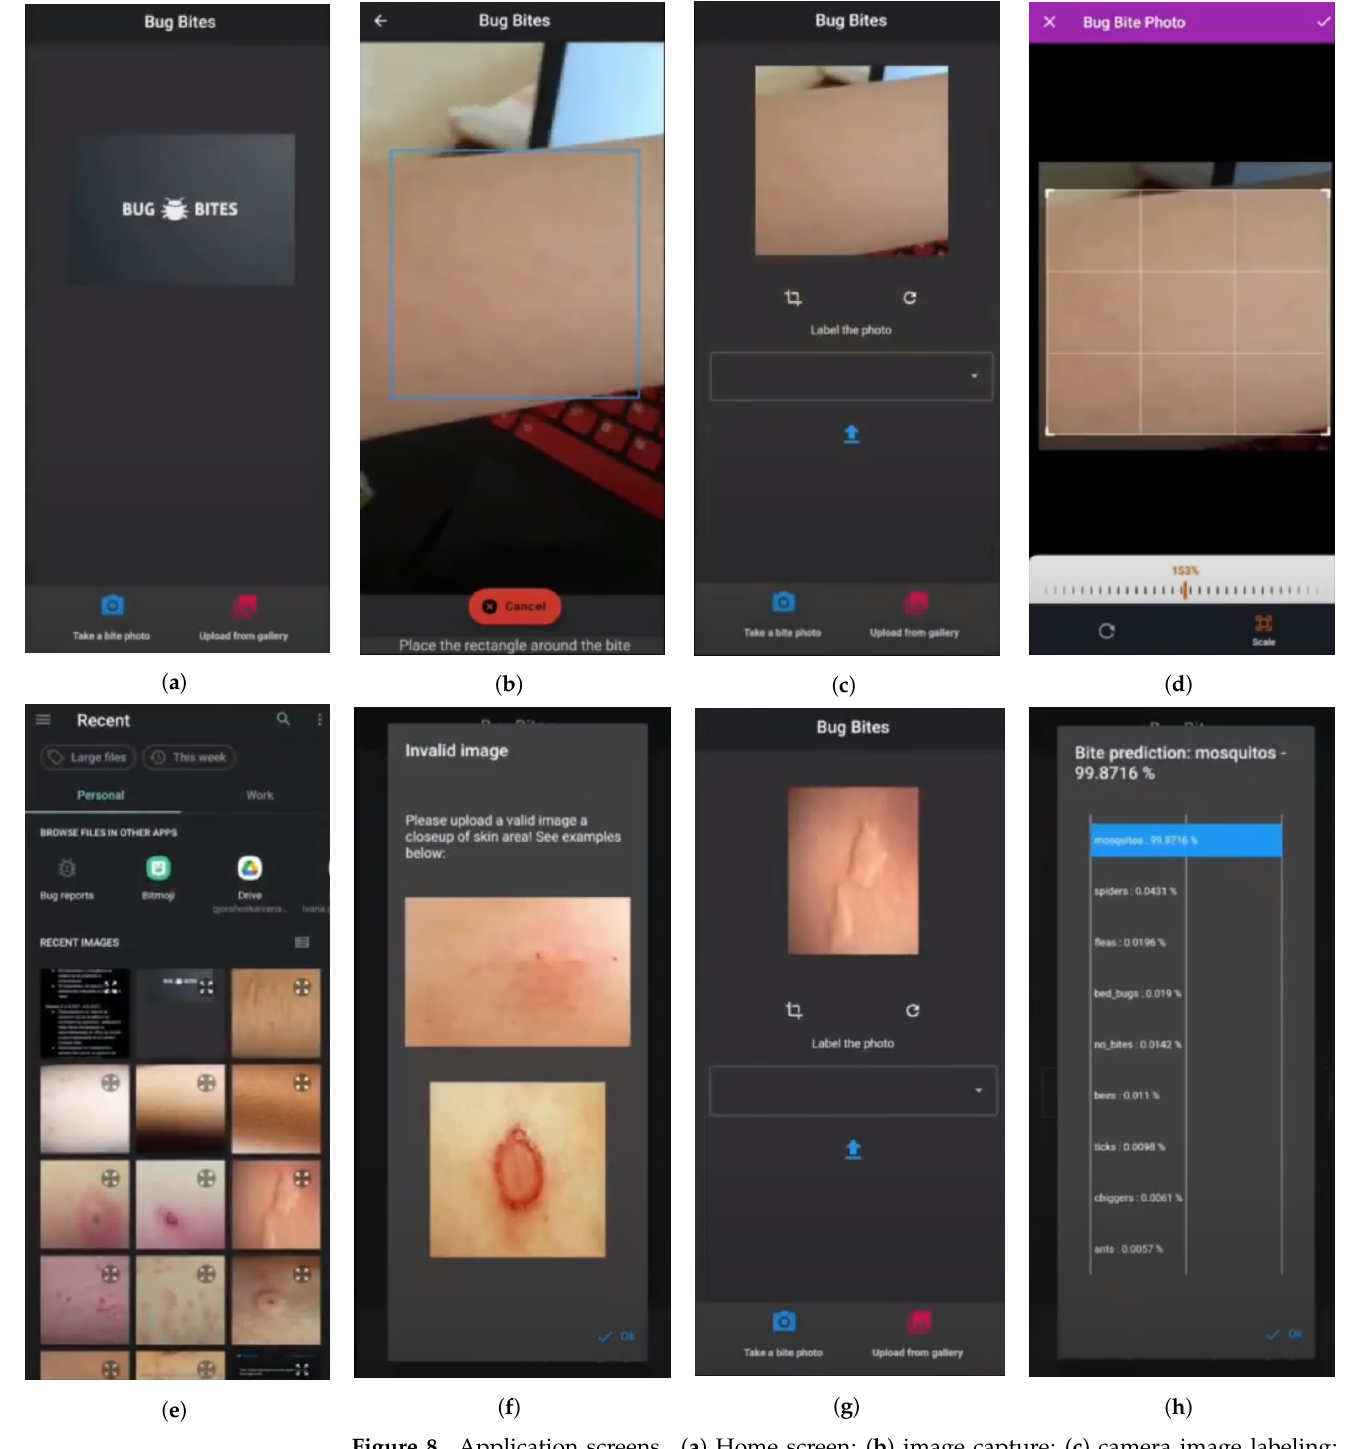
Figure 8. Application screens. ( a ) Home screen; ( b ) image capture; ( c ) camera image labeling; ( d ) photo editing; ( e ) choose from gallery; ( f ) invalid image selection; ( g ) camera image labeling; ( h ) bug bite